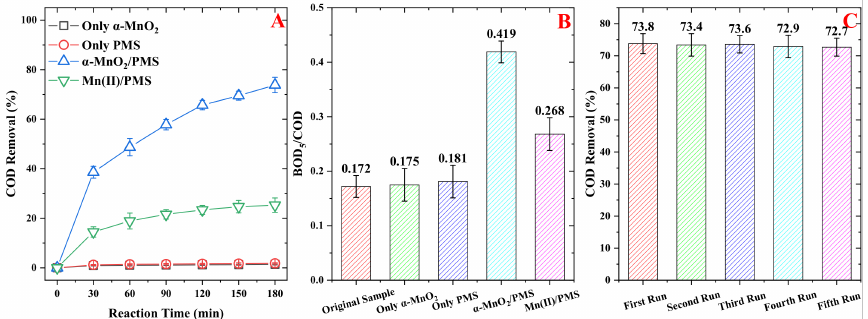
Figure 4. Removal of COD from coking wastewater ( A ), enhancement of the biodegradabil- ity index ( B ), and the reuse performance of α -MnO 2 /PMS process ( C ). Reaction conditions: [ α -MnO 2 ] 0 = 50 g/L, [Mn(II)] 0 = 50 mM, [PMS] 0 = 50 mM, pH 0 = 7.0, Temperature = 30 ◦ C.